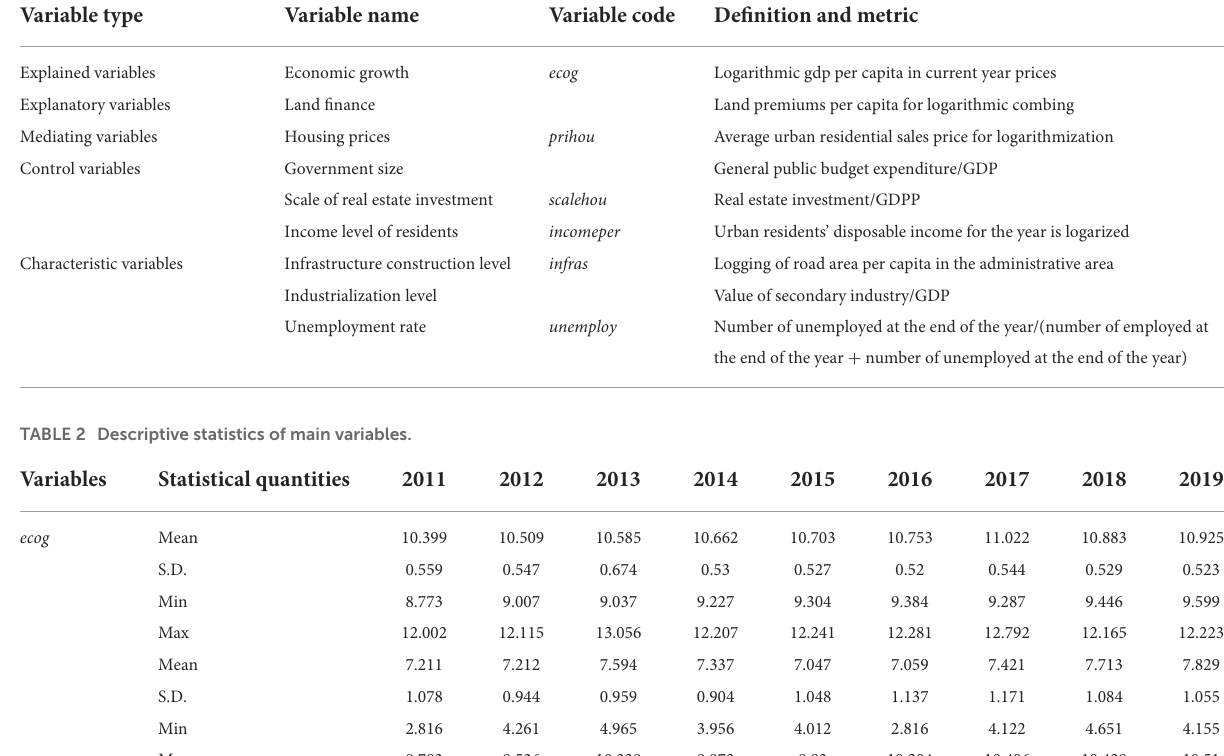
TABLE 1 Variables declarations.